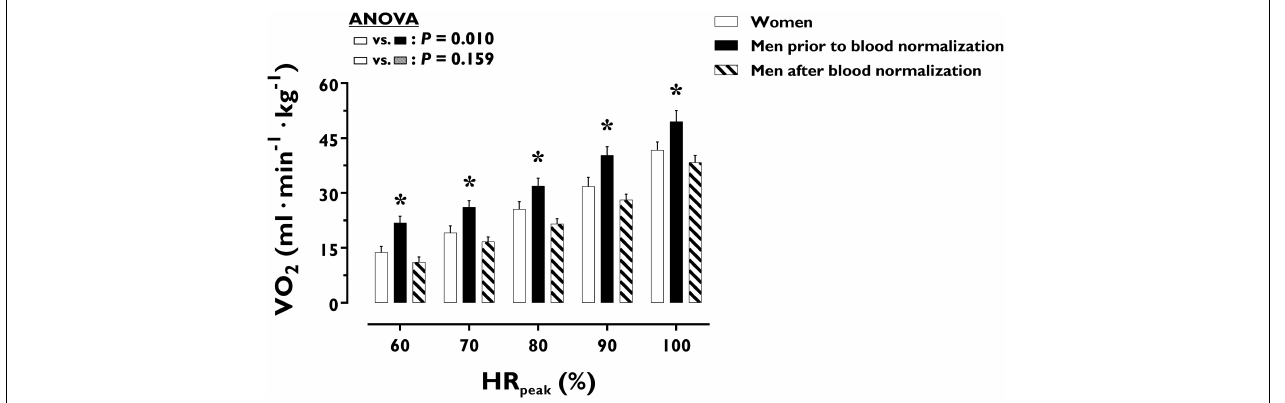
FIGURE 4 | Oxygen uptake during incremental exercise in women and men prior to and after blood normalization. * P < 0.05 between women and men prior to blood normalization. † P < 0.05 between women and men after blood normalization. Data are expressed as mean ± SEM. Number of biological observations in the graph: n = 210. Echocardiographic data were analyzed within ± 5 bmp of specific percentages of HR peak . HR peak , peak heart rate; VO 2 , oxygen uptake (per kg of body